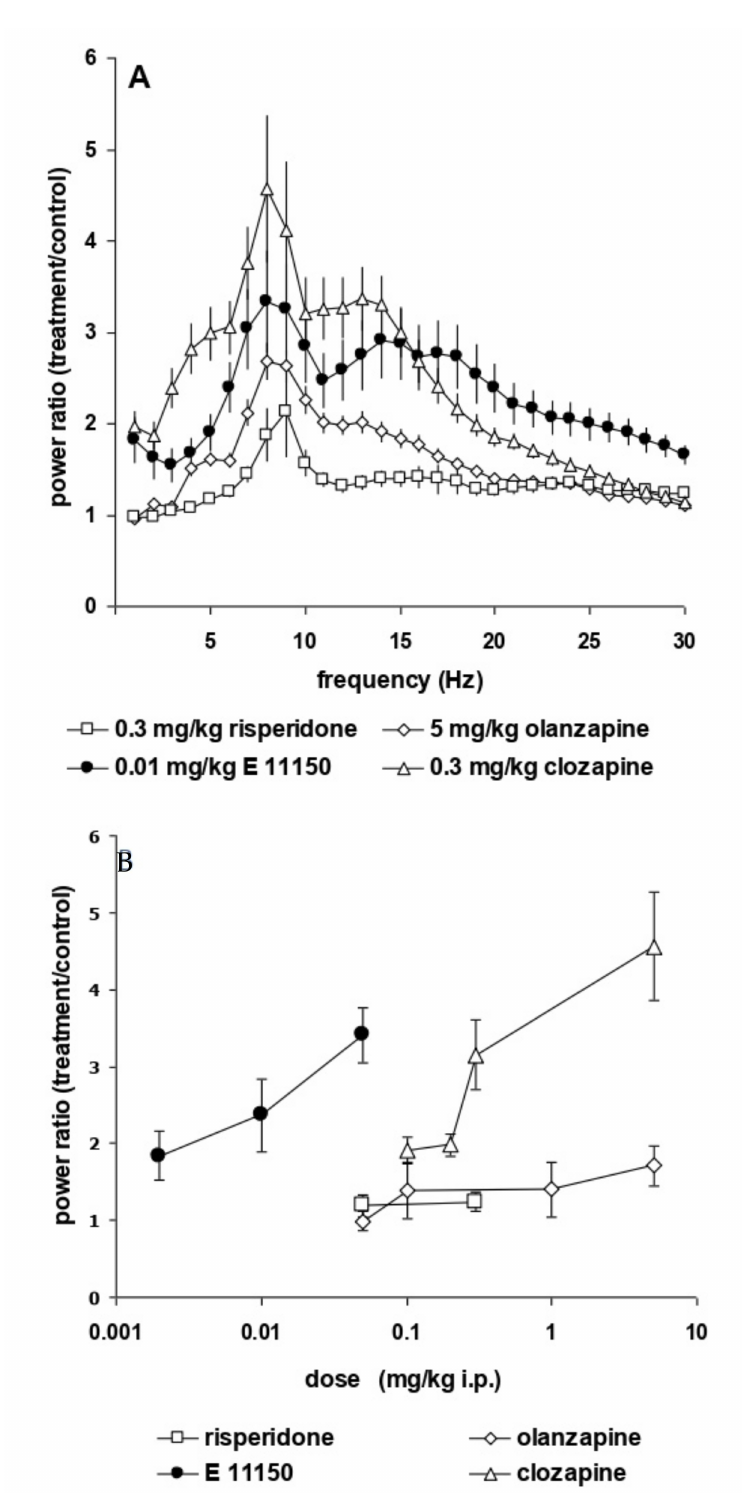
Figure 3. Comparison of the effects of EGIS-11150 on the EEG power spectrum with those of risperidone, olanzapine and clozapine. Panel ( A ) Composite graph of power spectra (total power) of the prefrontal cortex after administration of 0.3 mg/kg i.p. risperidone 5 mg/kg i.p.